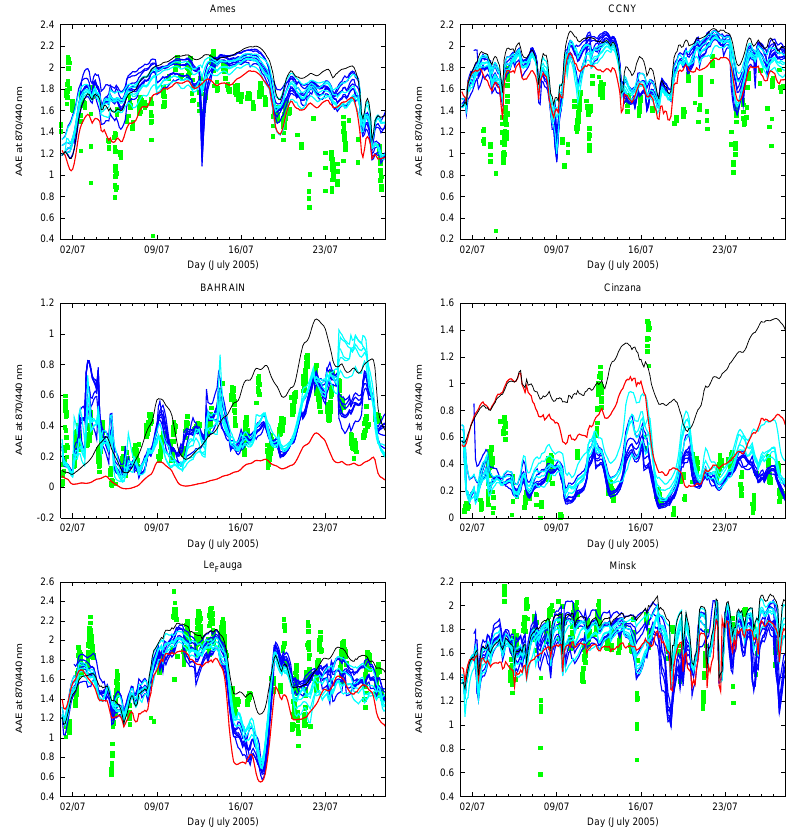
Fig. 21. AAE at selected AERONET sites for various experiments. In red the standard SPRINTARS simulation. In dark blue, experiments for n reg = 128 , in light blue, experiments for n reg = 1 . The free ensemble run for n ens = 128 is shown in black. Also shown are actual observations (green squares).